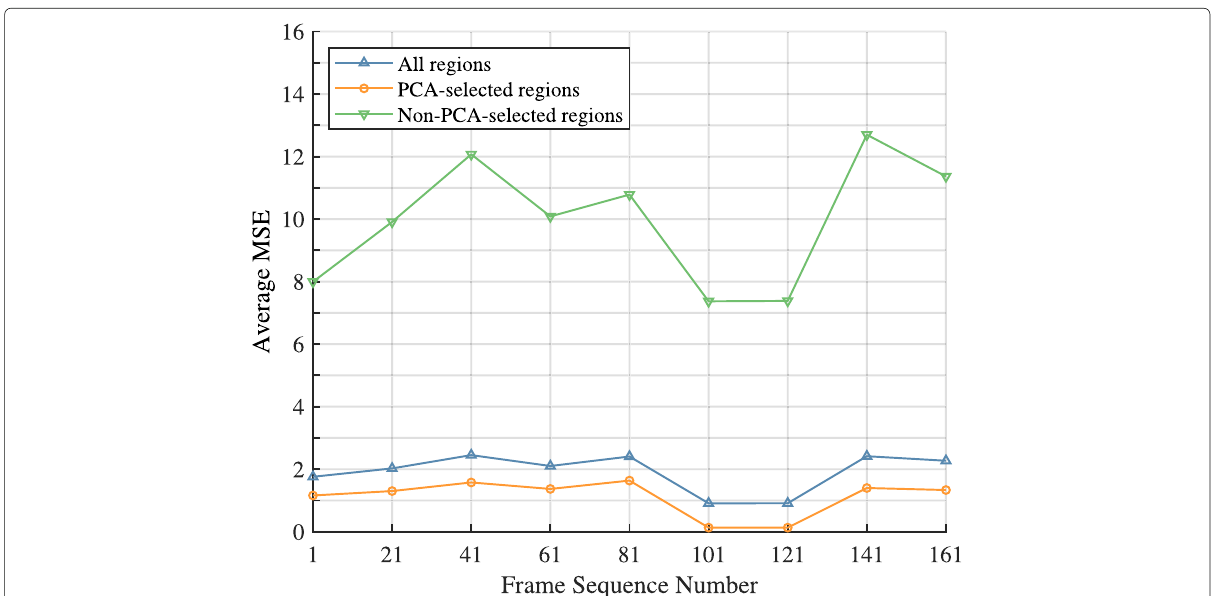
Fig. 4 The average MSE of all regions, PCA-selected regions, and non-PCA-selected regions within each